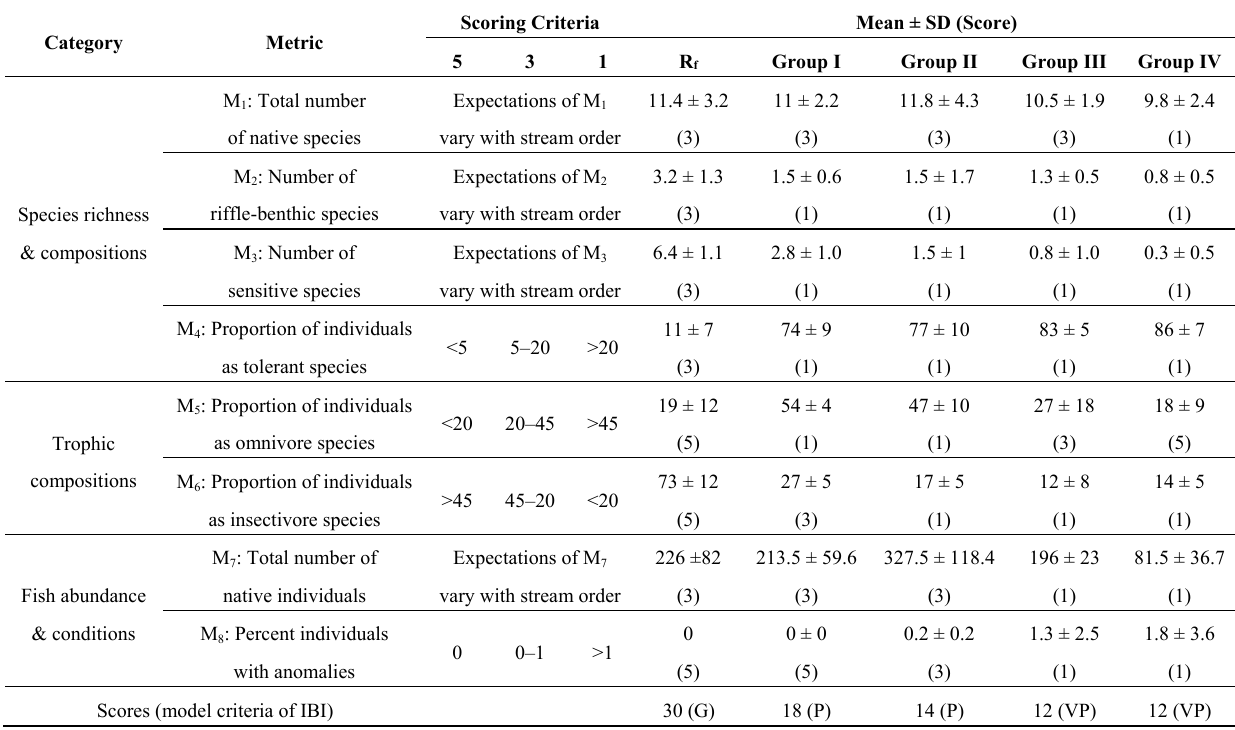
Table 4. Biological river health assessment, based on the multi-metric fish model of Index of Biological Integrity (IBI), in the watershed of Nakdong River.